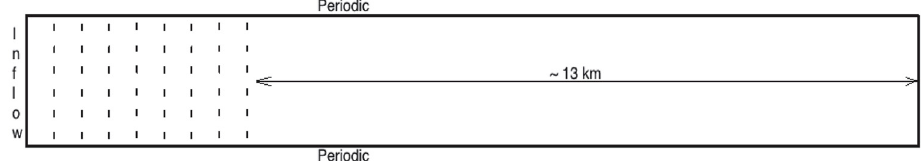
Figure 4. Wind farm layout and the shadow region in the downstream.